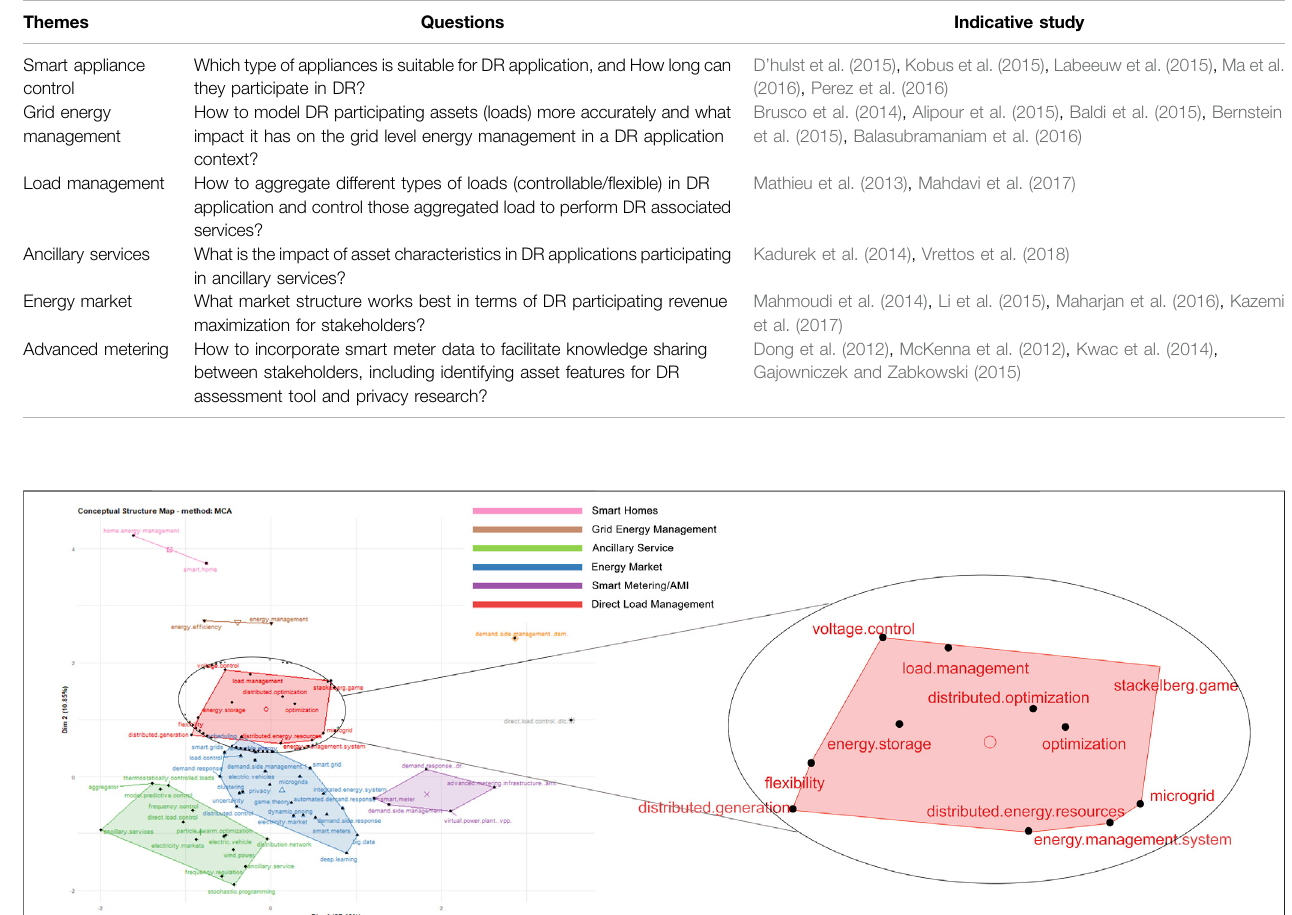
TABLE 4 | Outlook on demand response research themes with key research questions and indicative studies listed`.